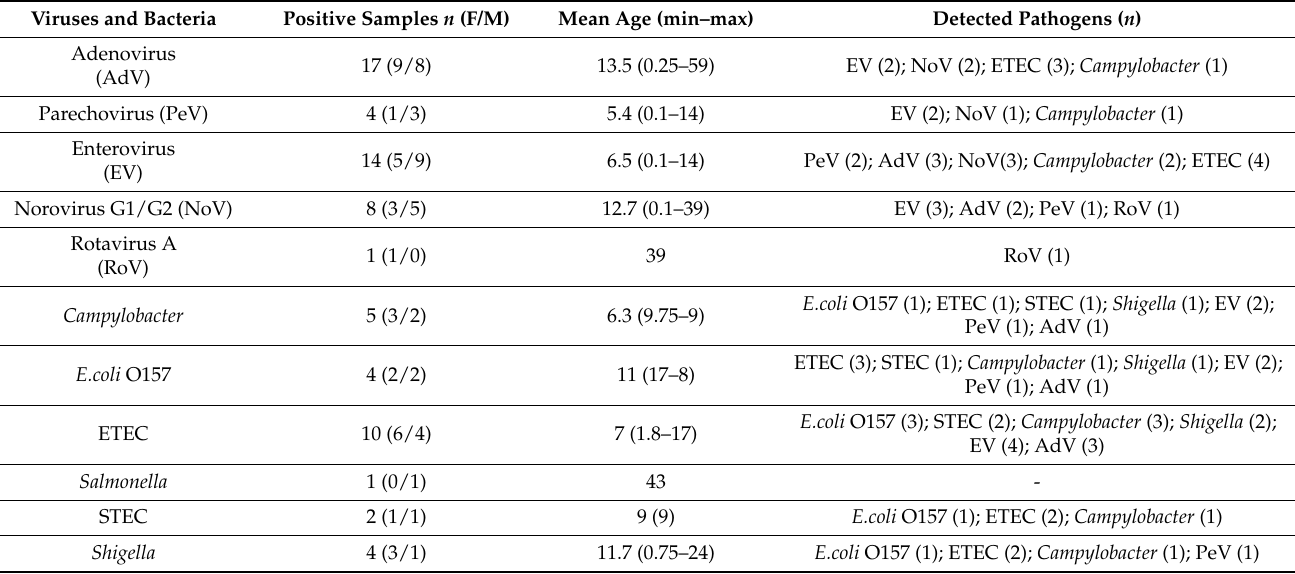
Table 2. Summary of detected bacterial and viral pathogens.